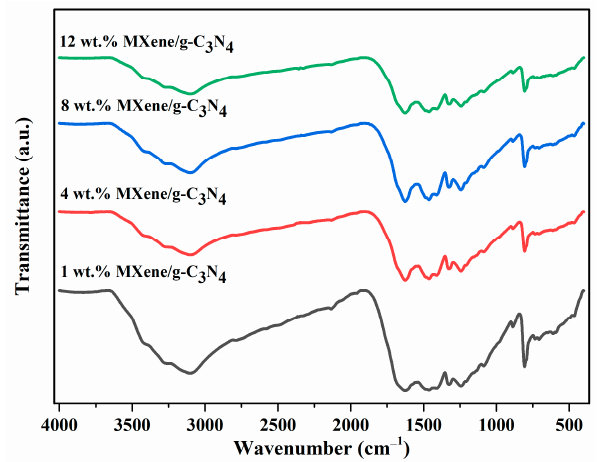
Figure 2. FTIR patterns of the as-prepared MXene/g-C 3 N 4